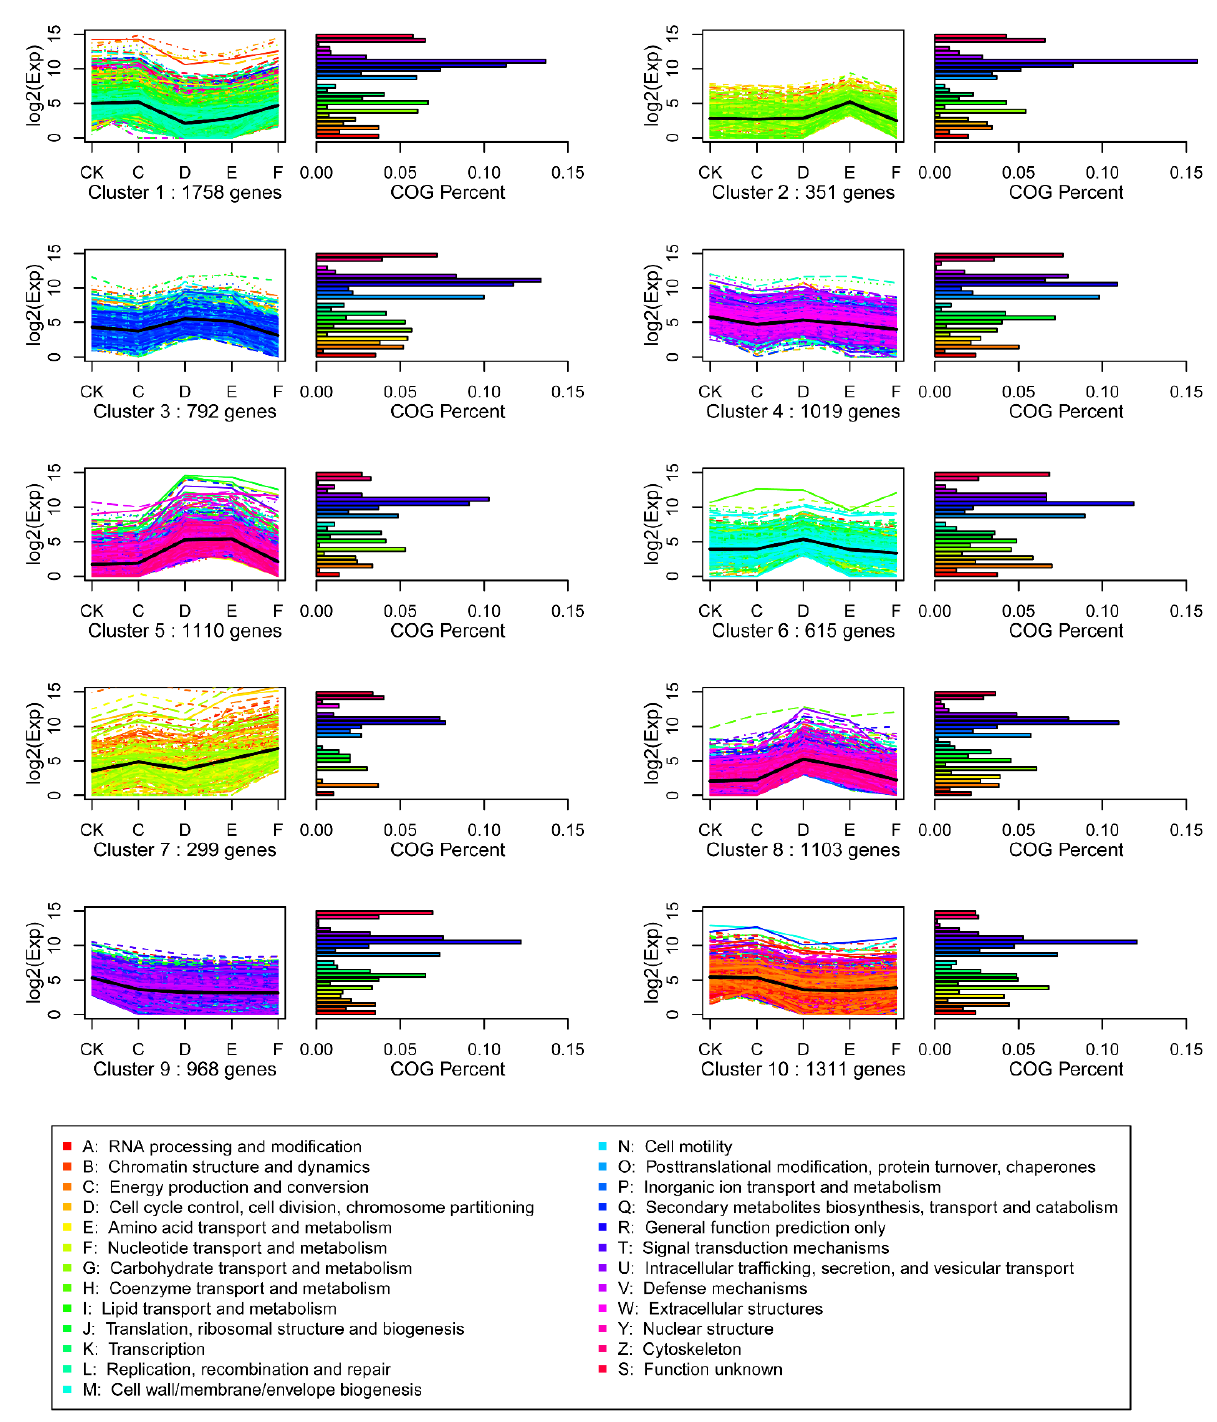
Figure 4. SOM cluster analysis of gene expression in the 10 different patterns. Clusters were obtained by the k-means method on the gene expression profiles of the 9326 modulated genes. The most abundant group is Clusters 1 and 10, with 1758 and 1311 genes whose expression shows a down-regulation in D relative to C. The second most abundant group is Clusters 5, 8, and 4, containing 1110, 1103, and 1019 genes, respectively, whose expression shows a positive slope from C to